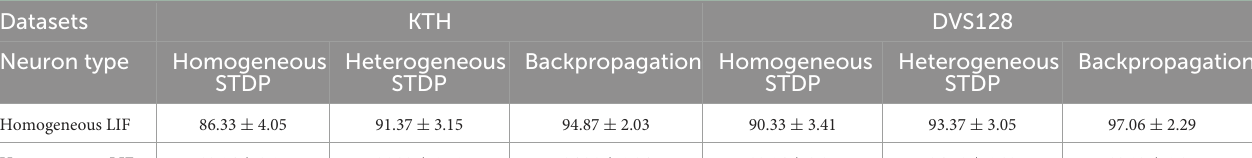
TABLE 1 Table comparing the performance of RSNN with homogeneous and heterogeneous LIF neurons using different learning methods with 2,000 neurons.